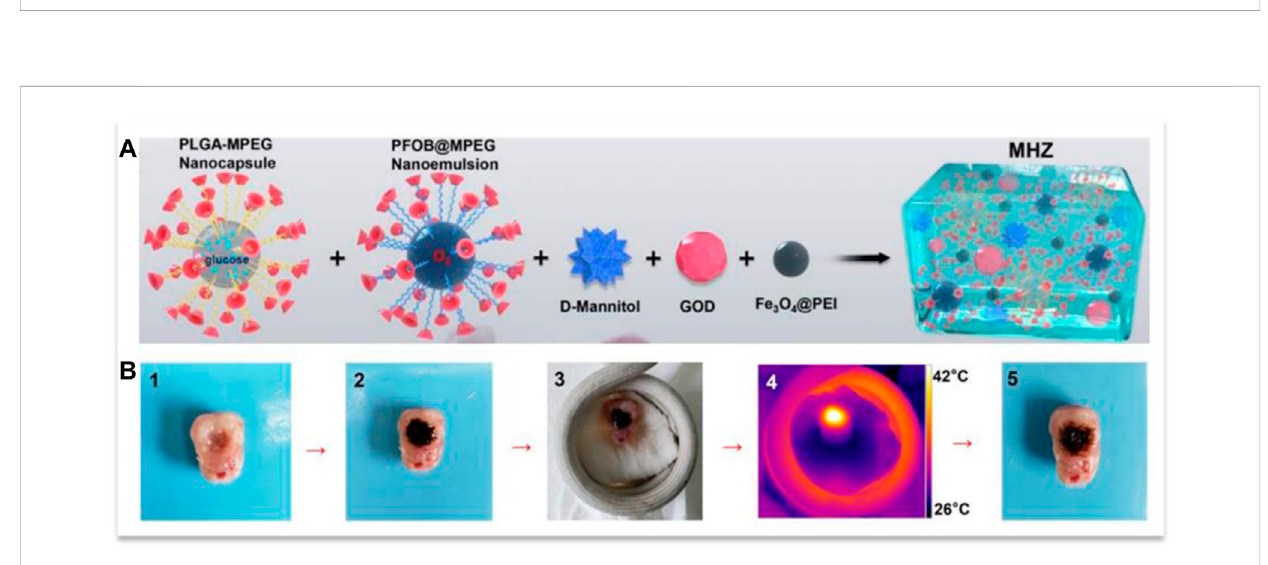
FIGURE 12 (A) the components of the gel and (B) its penetration into an isolated tumor during the application of a magnetic fi eld. Reprinted with permission from (Wu et al., 2019). Copyright 2019 American Chemical